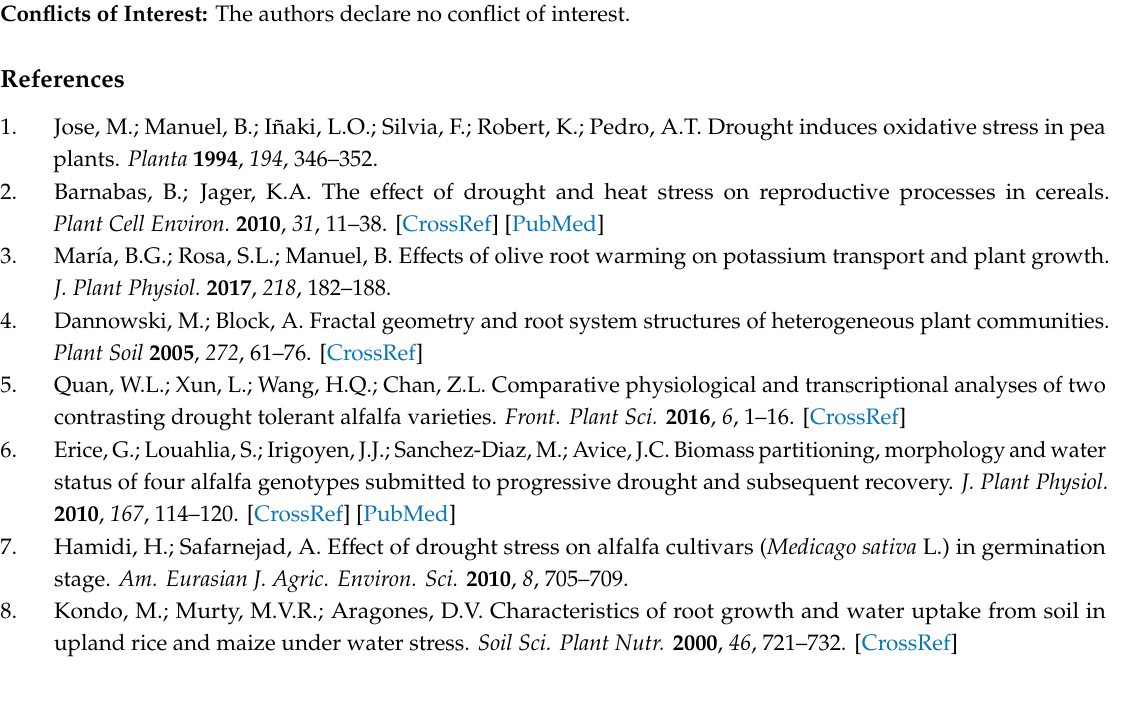
Table S1: Description of experimental treatments (I: 75–80% water holding capacity, II: 60–65% followed by rehydration to 75–80% water holding capacity, III: 45–50% followed by rehydration 60–65% and 75–80% water holding capacity, and IV: 30–35% followed by rehydration to 45–50%, 60–65%, and 75–80% water holding